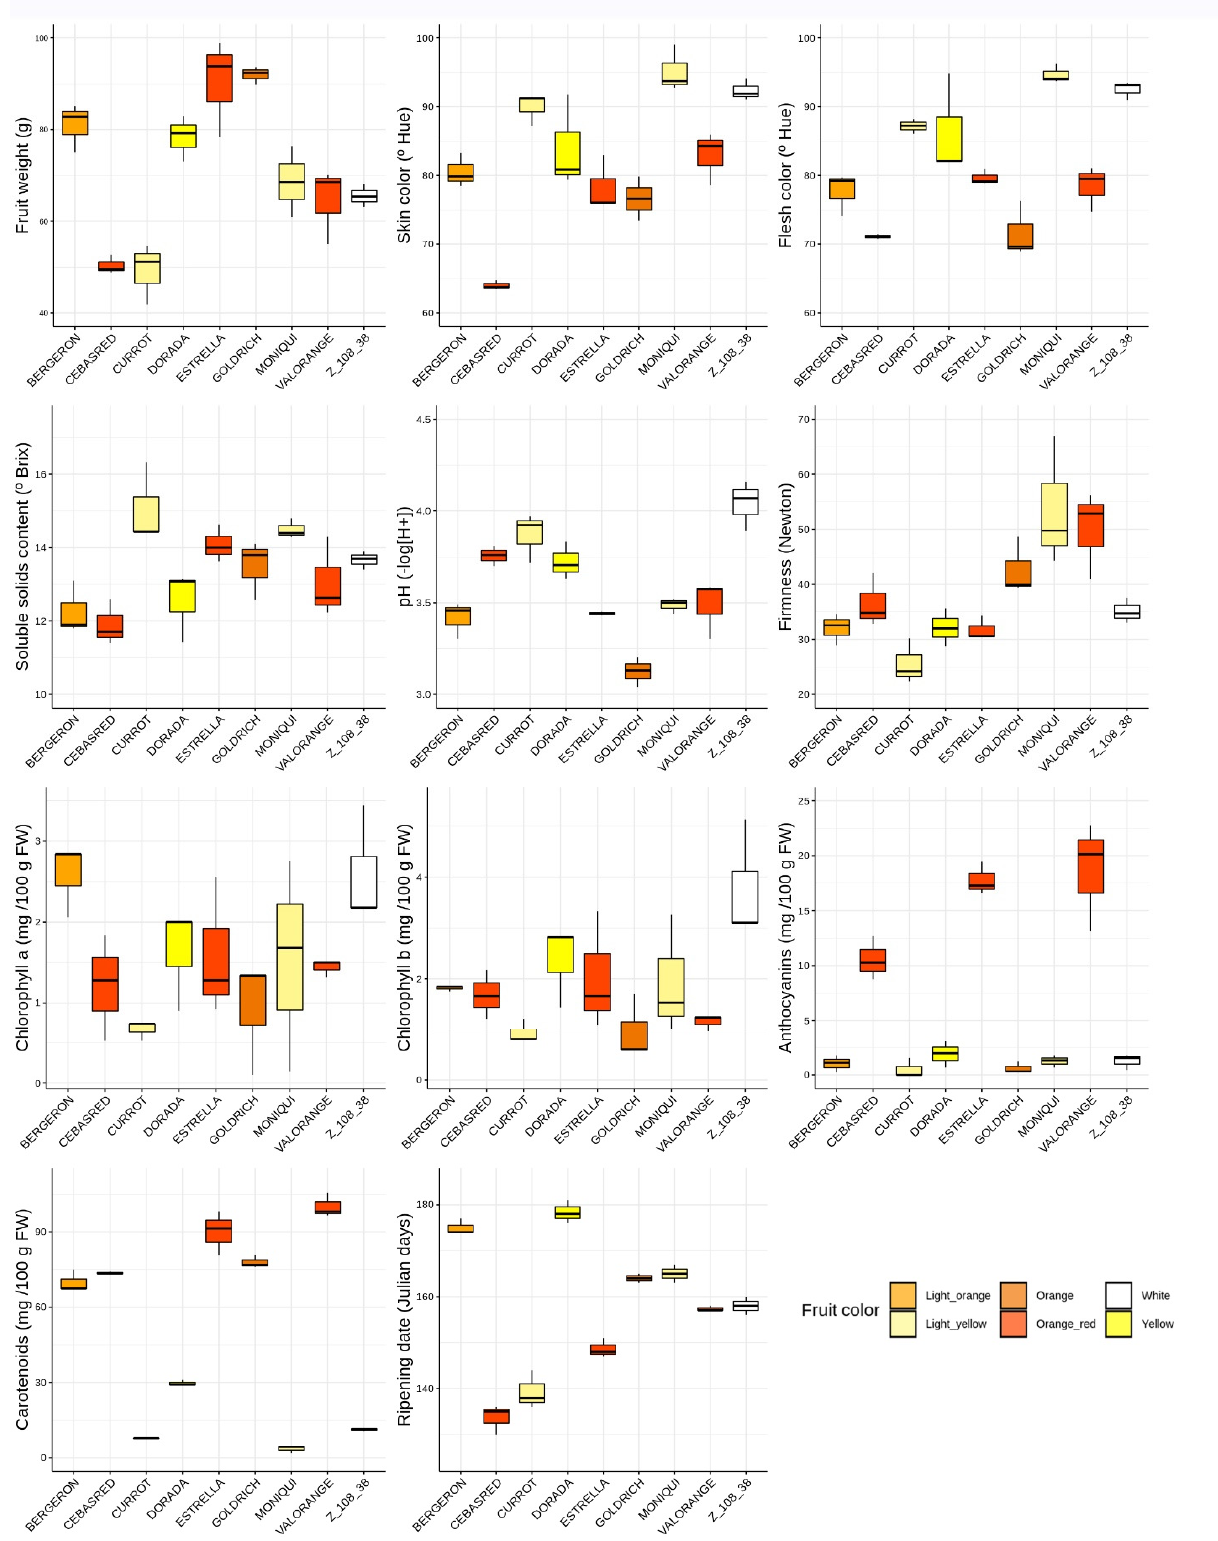
Figure 1. Phenological and fruit quality traits boxplots (fruit weight, skin color, flesh color, soluble solids content, acidity (pH), firmness, chlorophyll a, chlorophyll b, anthocyanins, carotenoids and ripening date) evaluation of the nine cultivars assayed, ‘Bergeron’, ‘Cebasred’, ‘Currot’, ‘Dorada’, ‘Estrella’, ‘Goldrich’, ‘Moniquí’, ‘Valorange’ and ‘Z 108-38 ′ at physiological ripening. Boxplots are filled with the fruit color of each cultivar.